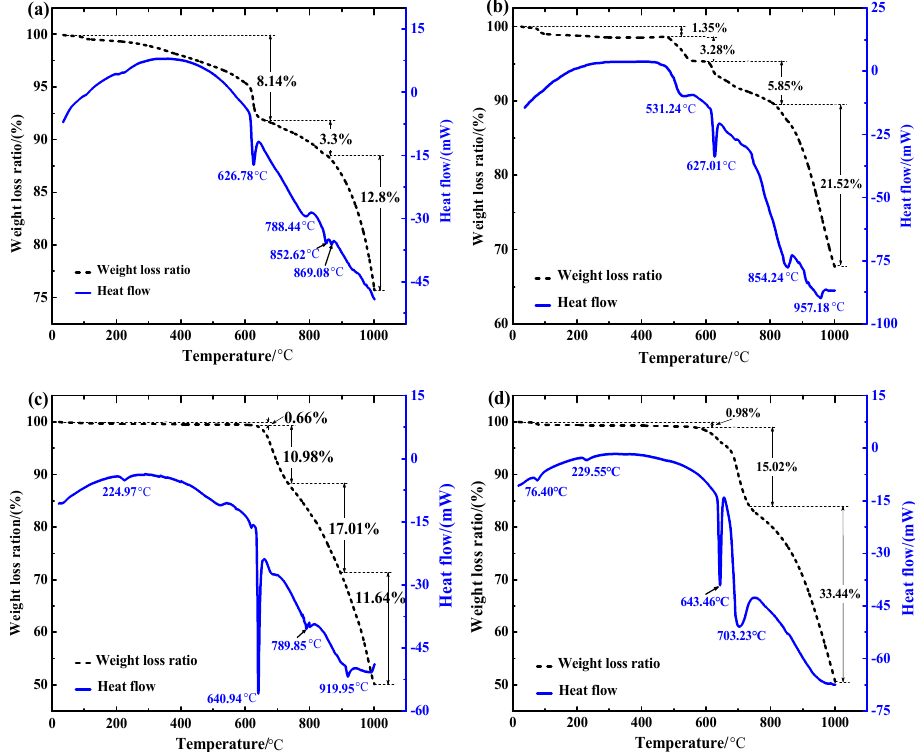
Figure 3. Thermogravimetric-differential scanning calorimetry (TG-DSC) diagrams of different impurities and molten salts ( a ) PbS with carbon addition, ( b ) FeS 2 with carbon addition, ( c ) SiO 2 without carbon addition, ( d ) CaCO 3 without carbon addition). Table 3. Possible reactions and their Δ G θ T values.